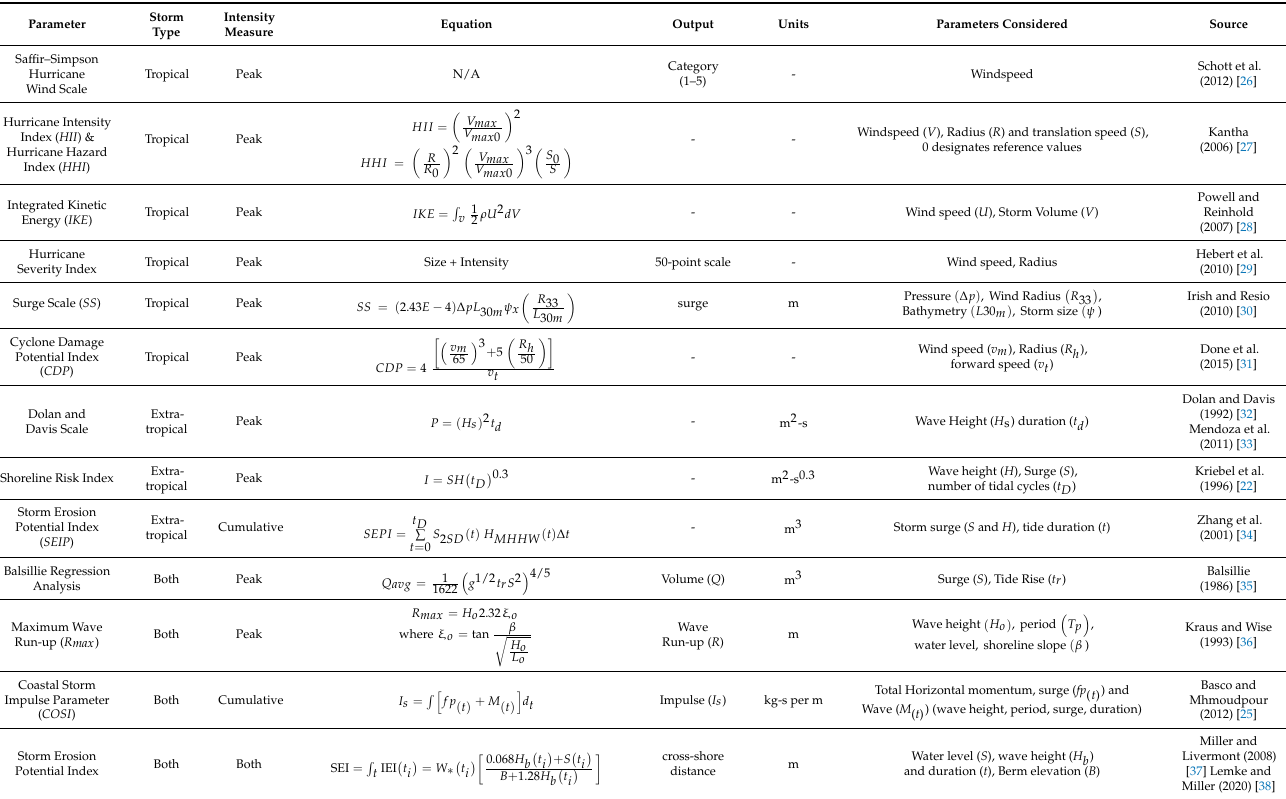
Table 1. Summary of available measures of Storm Intensity and key characteristics. Note variables are identified in ‘Parameters Considered’